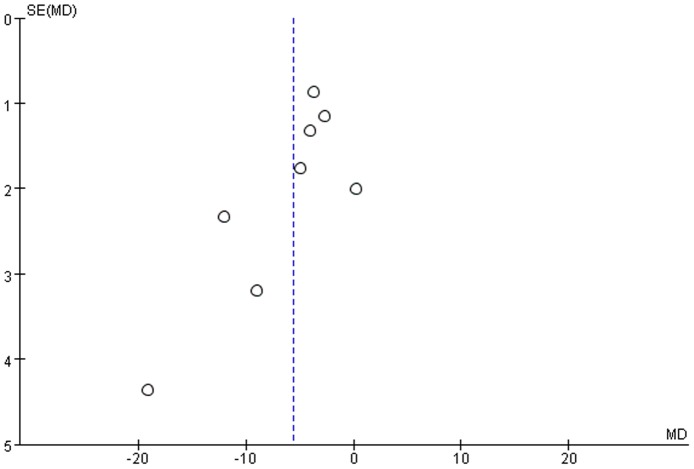
Funnel plots for ApoE levels in AD and healthy controls in included studies.Vertical dashed lines represent the summary weighted mean difference (WMD).